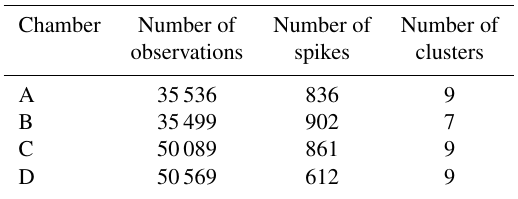
Table 4. Summary of spikes, observations and clusters detected fol- lowing the procedure explained in Sect. 2.4 for chambers A, B, C and